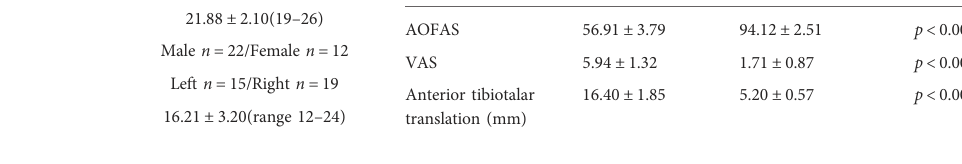
TABLE 1 Demographic data of all included patients (mean±standard deviation).